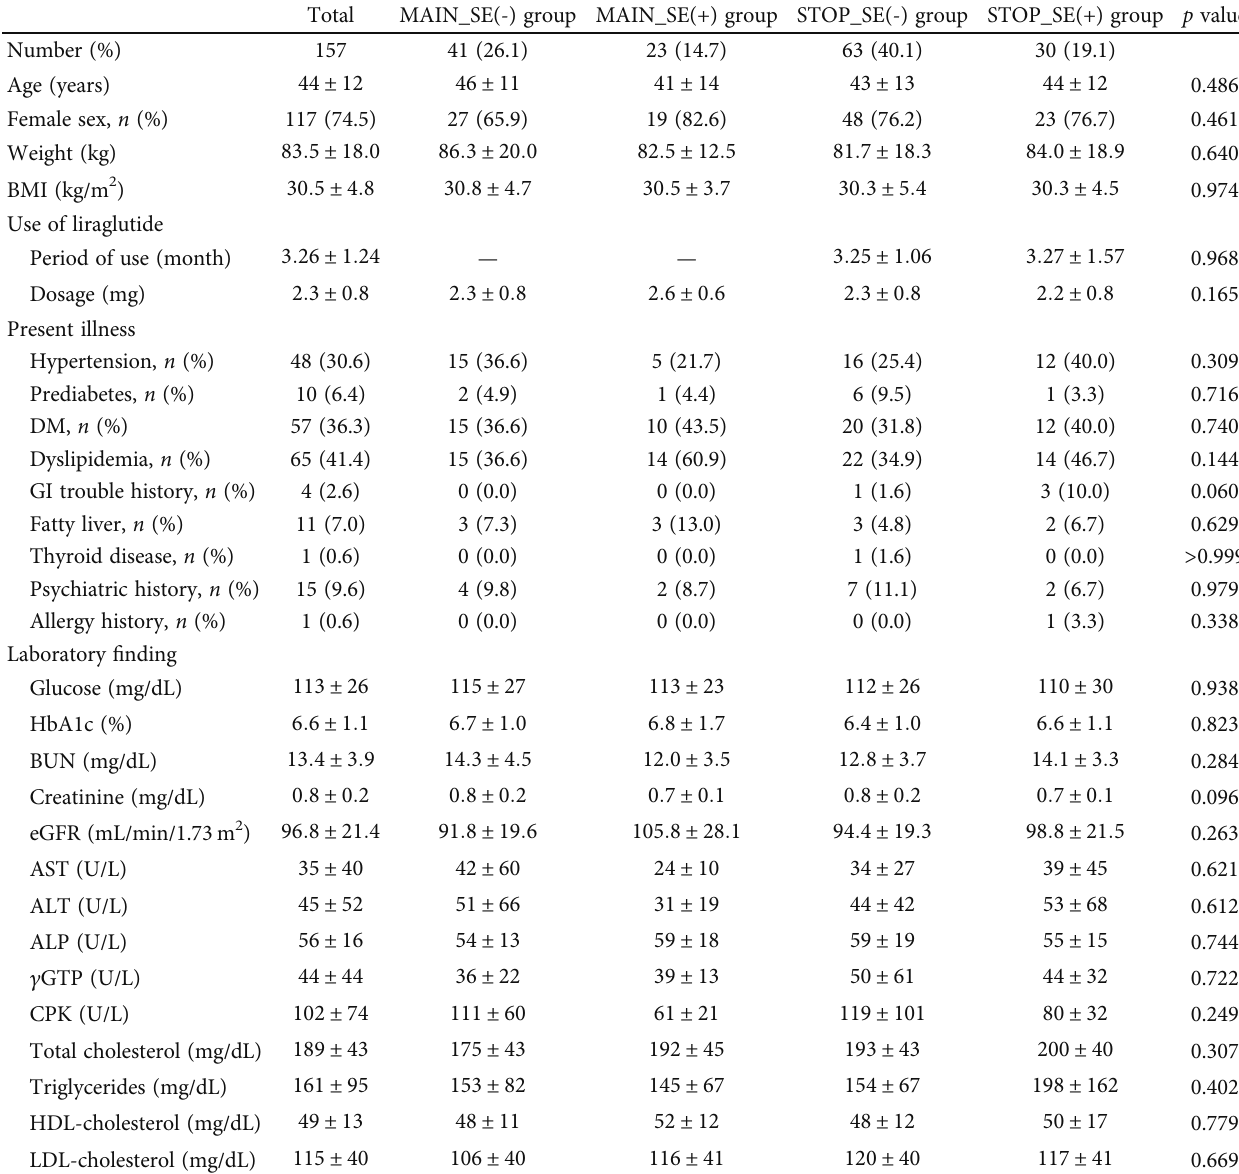
Table 1: Baseline characteristics of patients ( n = 157